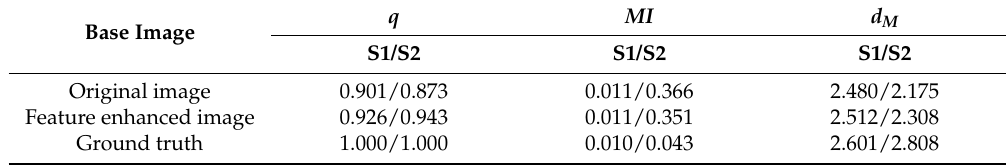
Table 3. Values of the evaluation metric on the reference segmentation results of S1 and S2.